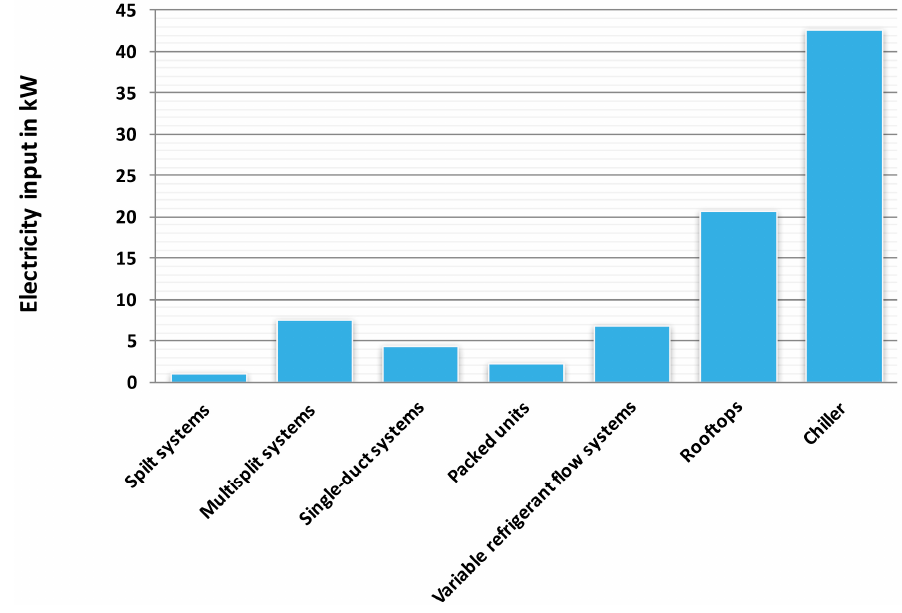
Figure 13. Electricity input per AC type, EU15 (see references in the Appendix A, Tables A4 and A5).